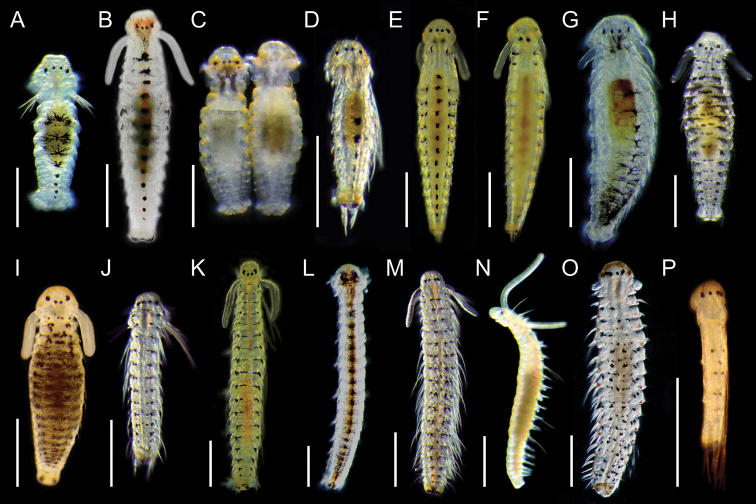
Light micrographs showing the morphologies of living spionid larvae of genera Boccardia, Boccardiella, and DipolydoraA, BBoccardia
proboscidea, dorsal view of accidentally hatched 9‐chaetiger (A) and 15‐chaetiger larvae (B) CBoccardia
pseudonatrix, dorsal (left) and ventral (right) view of accidentally hatched 10‐chaetiger larvae D–FBoccardia sp. 1, dorsal view of 9‐chaetiger (D) and dorsal (E) and ventral view (F) of 17‐chaetiger larvae GBoccardia sp. 2, dorsal view of 15‐chaetiger larva H, IBoccardiella
hamata, dorsal view of 16‐chaetiger (H) and 18‐chaetiger larvae (I) J, KDipolydora
bidentata, dorsal view of 13‐chaetiger (J) and 18‐chaetiger larvae (K) LDipolydora
cf.
commensalis, dorsal view of 21‐chaetiger larva M, NDipolydora
giardi, dorsal view of 19‐chaetiger (M) and lateral view of 21‐chaetiger larvae (N) ODipolydora
cf.
socialis, dorsal view of 18‐chaetiger larva PDipolydora sp., dorsal view of 7‐chaetiger larva. Scale bars: 300 μm.